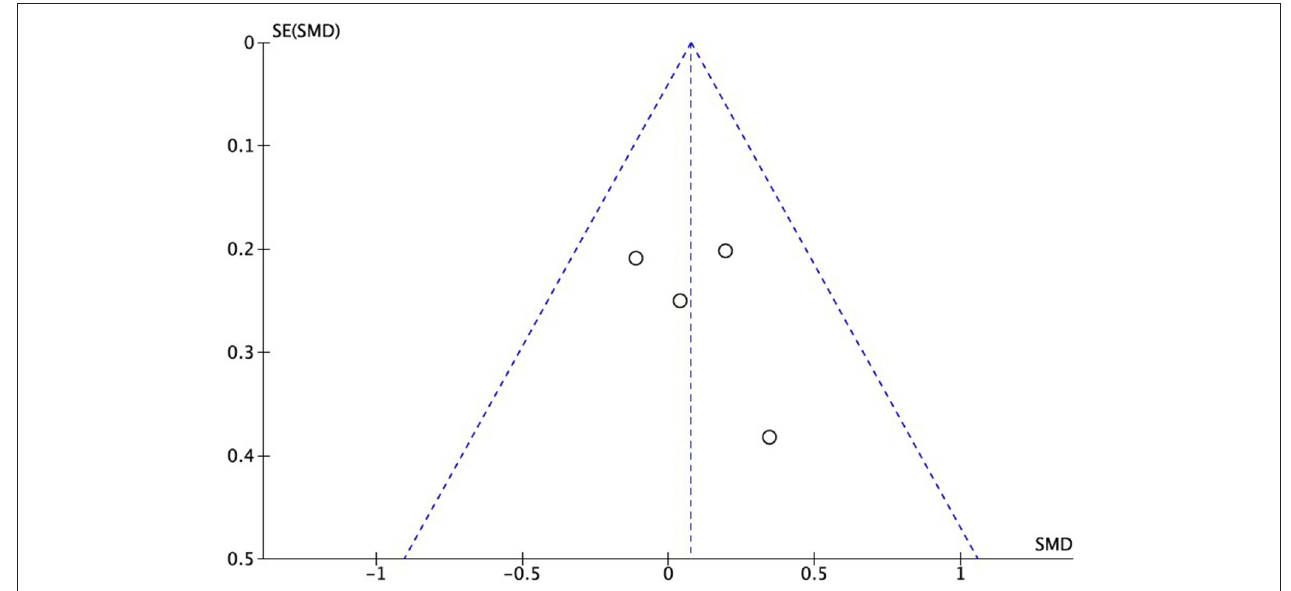
FIGURE 5 | Funnel Plot of publication